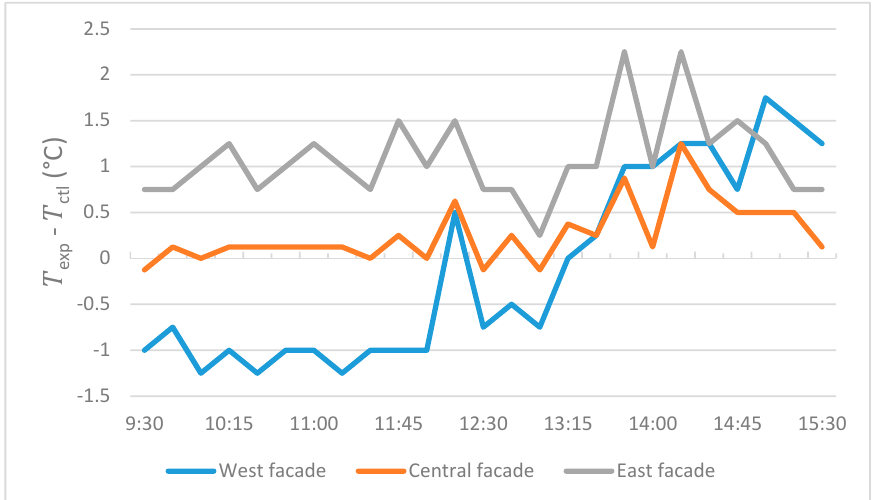
Figure 7. Cooling effect of tree shade on the target building facade temperature (One-tree, at the central part of front yard).